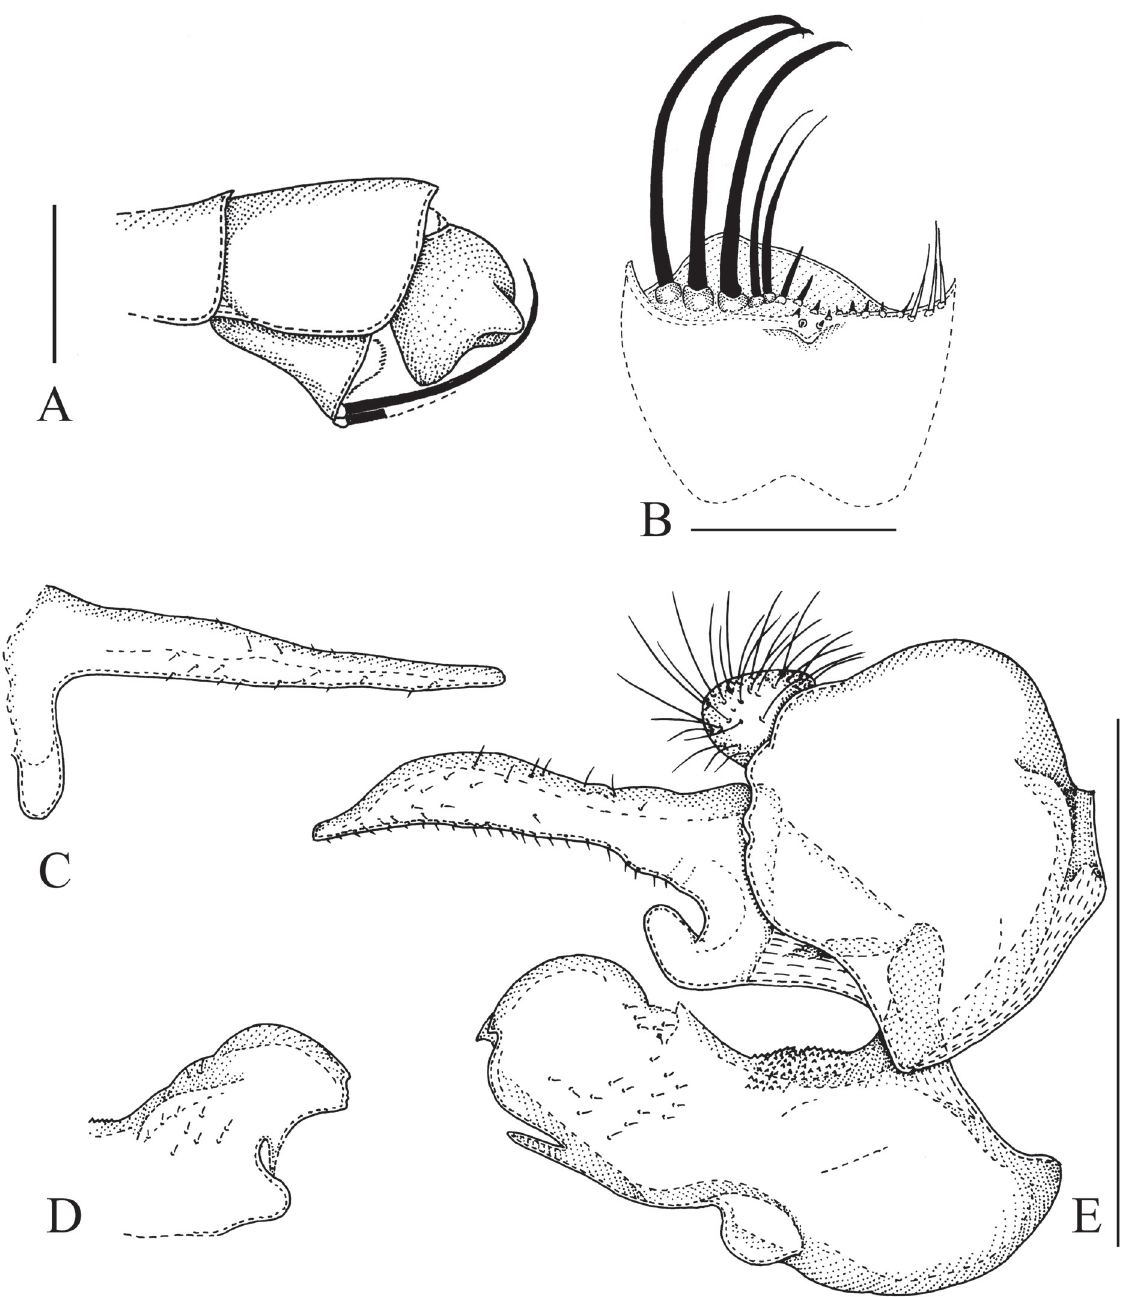
Fig. 96. Sphegina (Asiosphegina) verrucosa sp. nov., holotype, ♂ . A . Posterior part of abdomen, left side lateral view. B . Sternum IV, ventral view. C. Left su rstylus, lateral view. D . Left superior lobe with associated parts, lateral view. E . Genitalia, right side, lateral view. Scale bars =